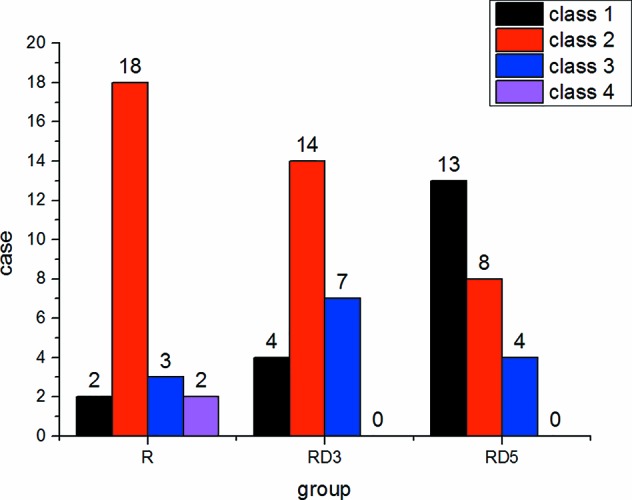
Shivering in the three groups.